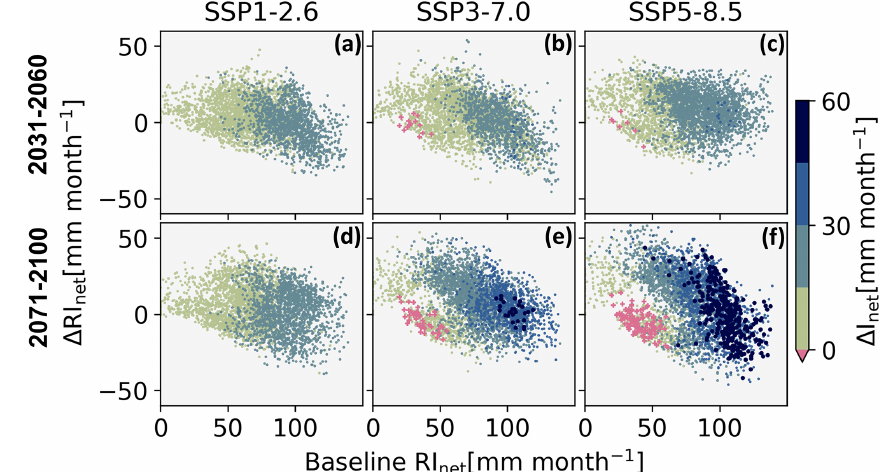
Figure 8. Scatterplots of (cid:49) RI net versus baseline range for the two future periods (rows) and the three scenarios (columns). The dots are colored by (cid:49)I net of the corresponding time window and scenario. Negative (cid:49)I net are marked with pink crosses, and extreme increases in (cid:49)I net ( > 45mm per month) are represented as dark blue larger dots. All values (RI net and (cid:49)I net ) are medians across the GCMs (mm per month).